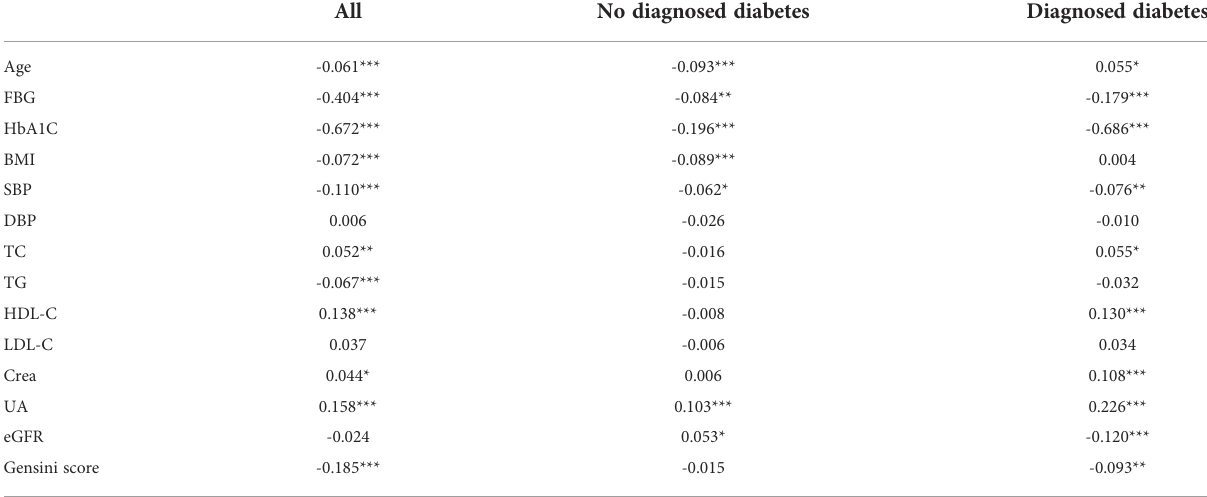
TABLE 2 Spearman correlation (r) of 1,5-AG with other clinical parameters.